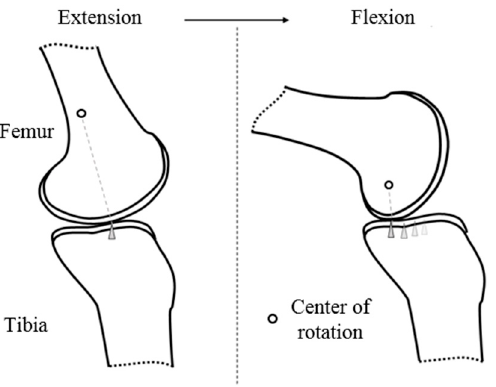
Figure 4. The movement of the femur on the tibia plane. The contact points between the tibia and the femur are illustrated as a triangle. We can also confirm that the center of rotation changes.